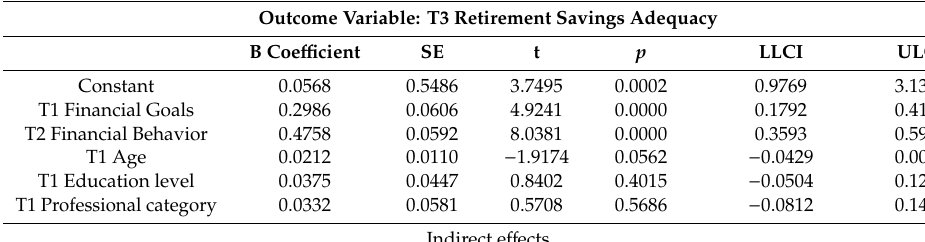
Table 2. Results for the Simple mediation